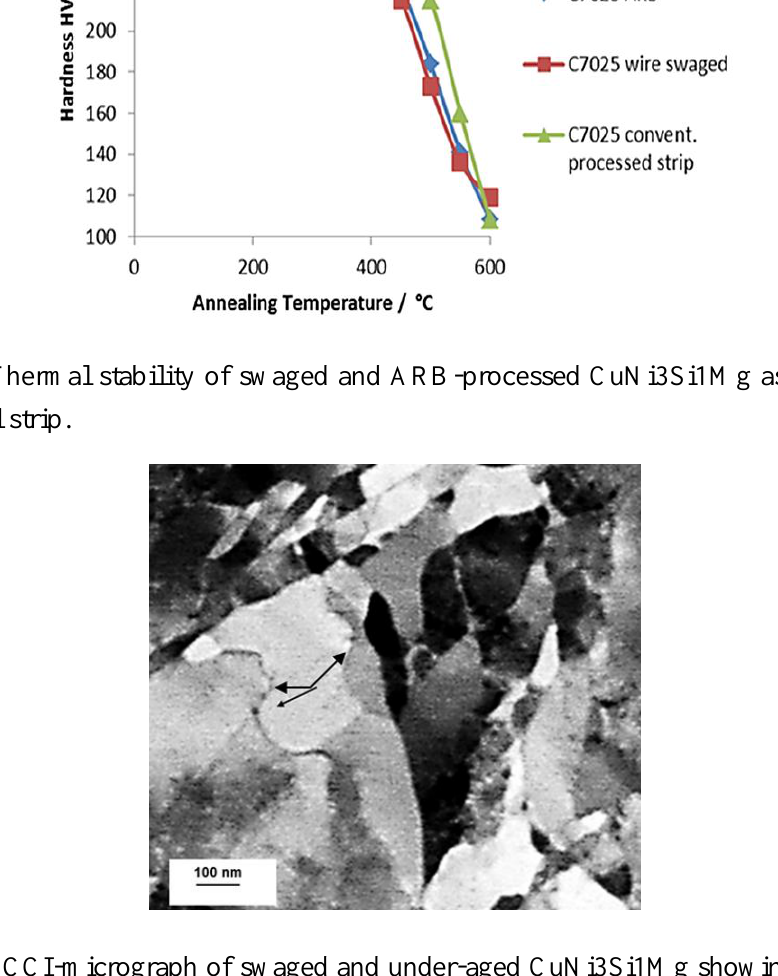
Figure 13. ECCI-micrograph of swaged and under-aged CuNi3Si1Mg showing a low-angle grain boundary which is pinned by Ni-silicides